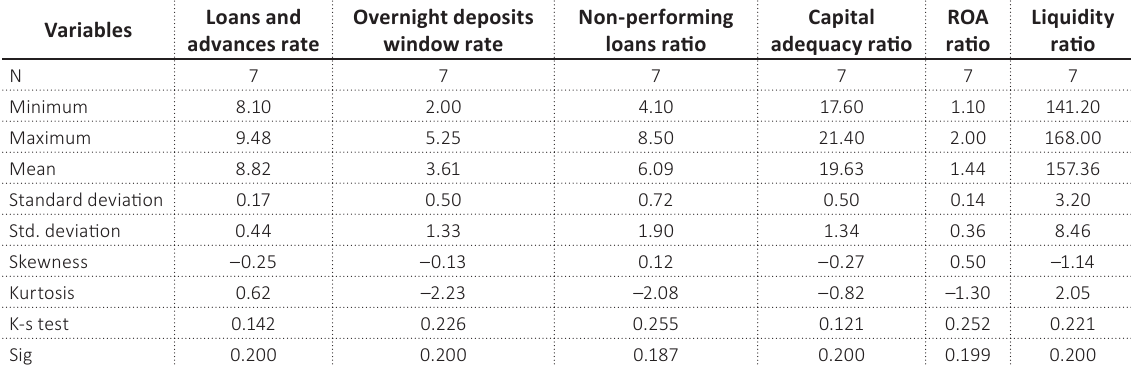
Table 3. Descriptive statistics for the study variables during 2005–2011